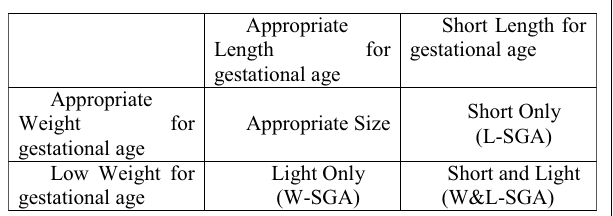
FIGURE 1 | Mutually exclusive combinations of short length and low weight for gestational age